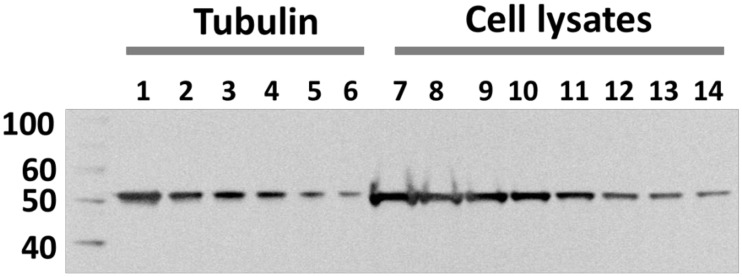
Tubulin contents in MCF7 cells.Tubulin isolated from MCF7 cells used as a standard (lanes 1–6; 278, 185, 130, 93, 56, 37 ng/lane, respectively), or MCF7 cell lysates (lanes 7–14; 7.7, 5.2, 3.9, 2.6, 1.8, 1.0, 0.77, 0.52 x104 cells/lane, respectively) were resolved by SDS-PAGE. Three independent experiments produced similar results.